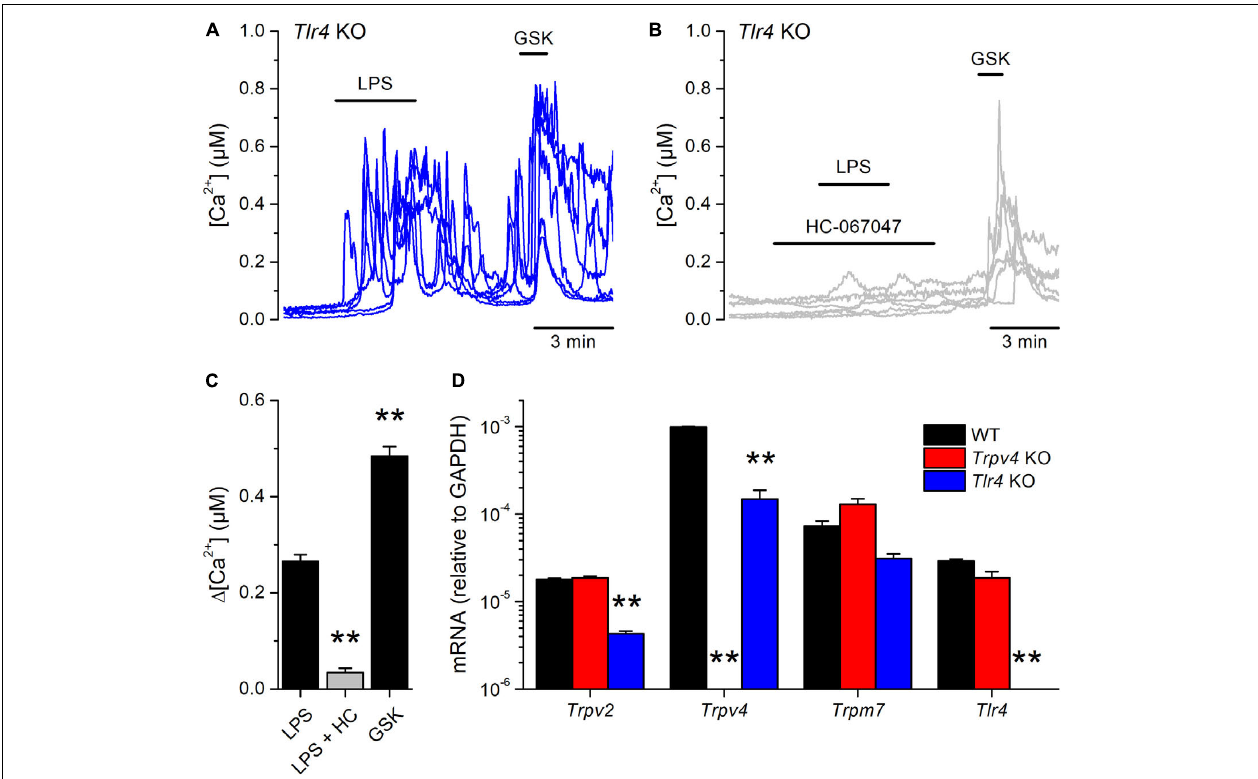
FIGURE 4 | TLR4 is dispensable for the acute response to E. coli LPS in mouse urothelial cells. (A,B) Representative intracellular Ca 2 + signals recorded in urothelial cells isolated from Tlr4 KO mice. LPS (20 µ g/ml) was perfused in control (A) or in the presence of the TRPV4 inhibitor HC-067047 (10 µ M) (B) . GSK1016790A (GSK, 10 nM) was applied to assess the functional expression of TRPV4. (C) Average amplitude of responses to LPS (20 µ g/ml) in control ( n = 151) or in the presence of HC-067047 (HC, 10 µ M) ( n = 148) in urothelial cells isolated from Tlr4 KO mice. The average amplitude of the responses to GSK1016790A (GSK, 10 nM) in control ( n = 151) is also shown for comparison. The ** symbols indicate P < 0.01 with a Dunn’s multiple comparison test. (D) Expression levels of Trpv2 , Trpv4 , Trpm7 and Tlr4 mRNA transcripts in urothelial cells derived from WT, Trpv4 KO and Tlr4 KO mice. The bars represent mean ± SEM, ( n = 3). The ** symbols indicate P < 0.01 with a Tukey’s multiple comparison